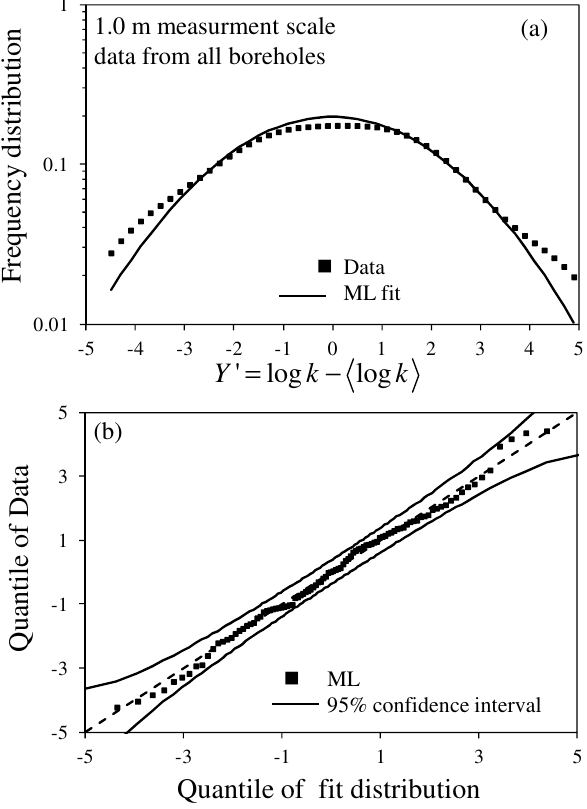
Fig. 2. (a) Frequency distribution (symbols) and ML esti- mated probability density function (solid curve) of Arizona data; (b) Q - Q plot of empirical data versus theoretical estimate of stable